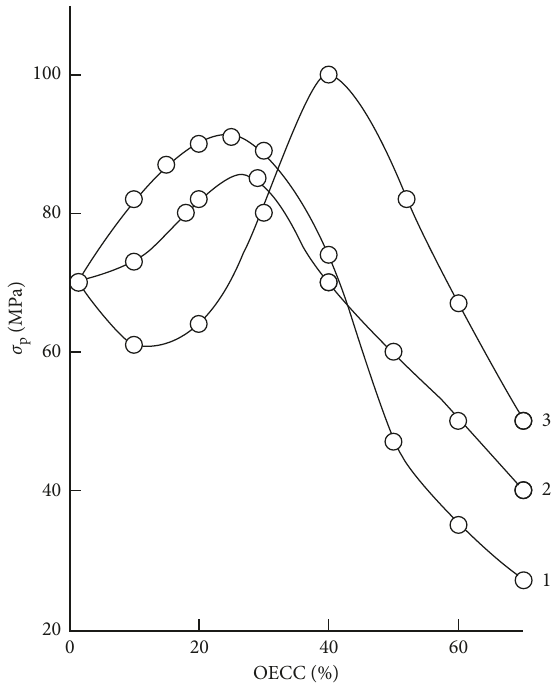
Figure 8: Dependence of the tensile strength of polymers obtained on the basis of ED-20 +OECC +DETA compositions, on the concentration and modifier type DCC/UP-675 (1), DCC/UP-650D (2), and DCC-181 (3).